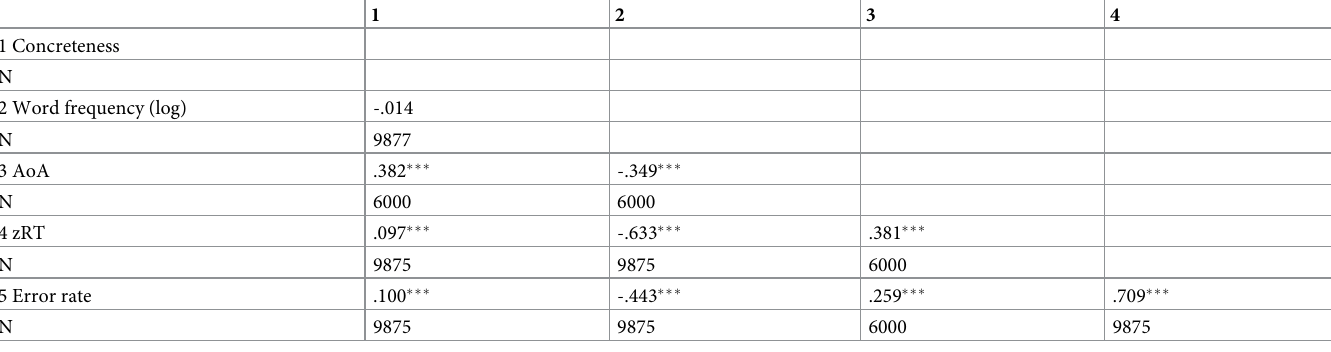
Table 3. Correlations of concreteness ratings, word frequency, age-of-acquisition (AoA), zRT, and error rate.